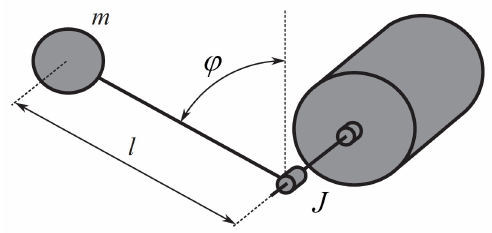
Figure 5. Robot manipulator